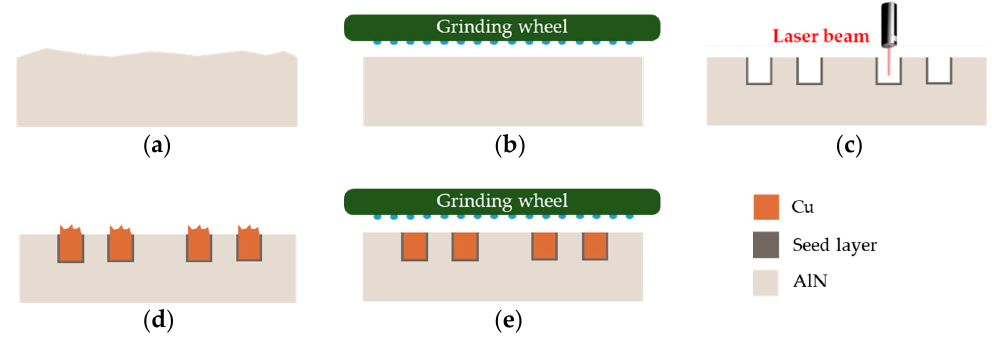
Figure 7. Schematic process flow for micro coil manufacturing with integrated copper conductors: ( a ) Carrier substrate (as fired surface); ( b ) Surface finish; ( c ) Laser micromachining; ( d ) Copper ECD; ( e ) Coarse and fine surface grinding of the copper outgrowth and the AlN surface.